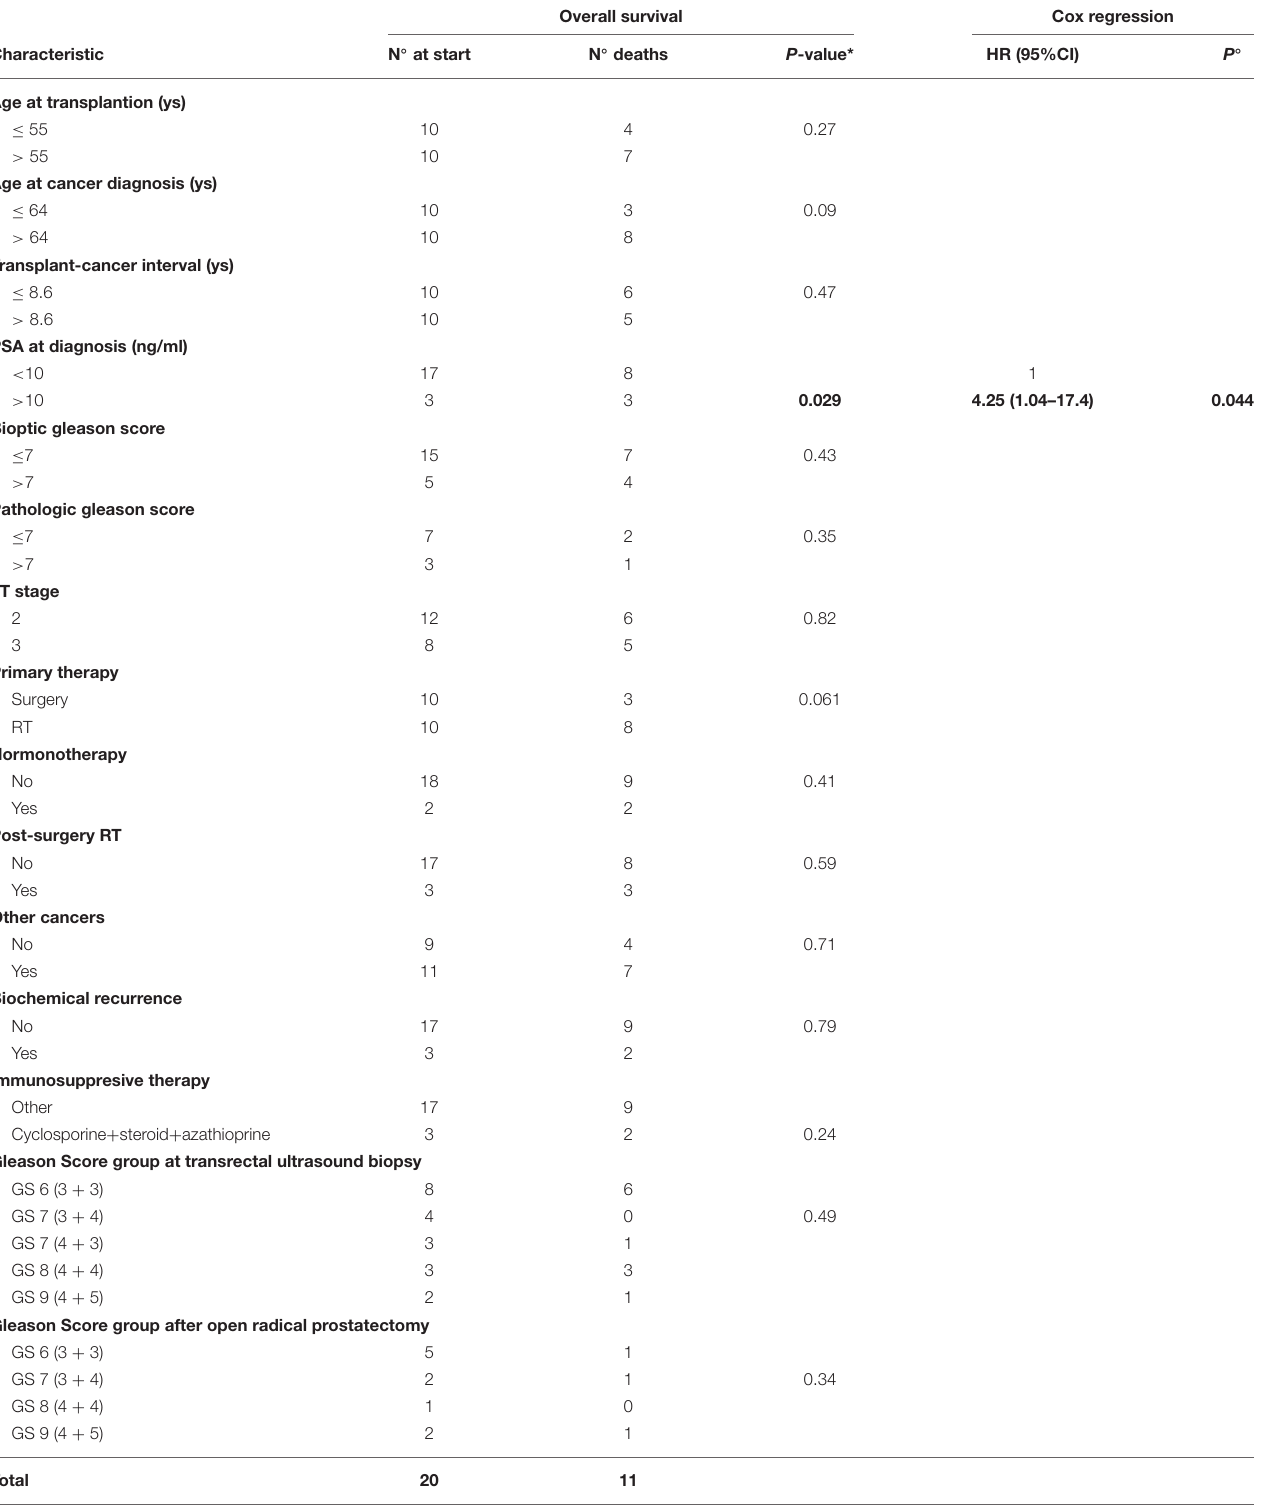
TABLE 3 | Kaplan Meier overall survival (OS) analysis of 20 PCa cases after kidney transplantation: patients at start, events (deaths), p -value from log rank test, hazard ratios with 95% confidence intervals from cox regression analysis. Overall survival Cox